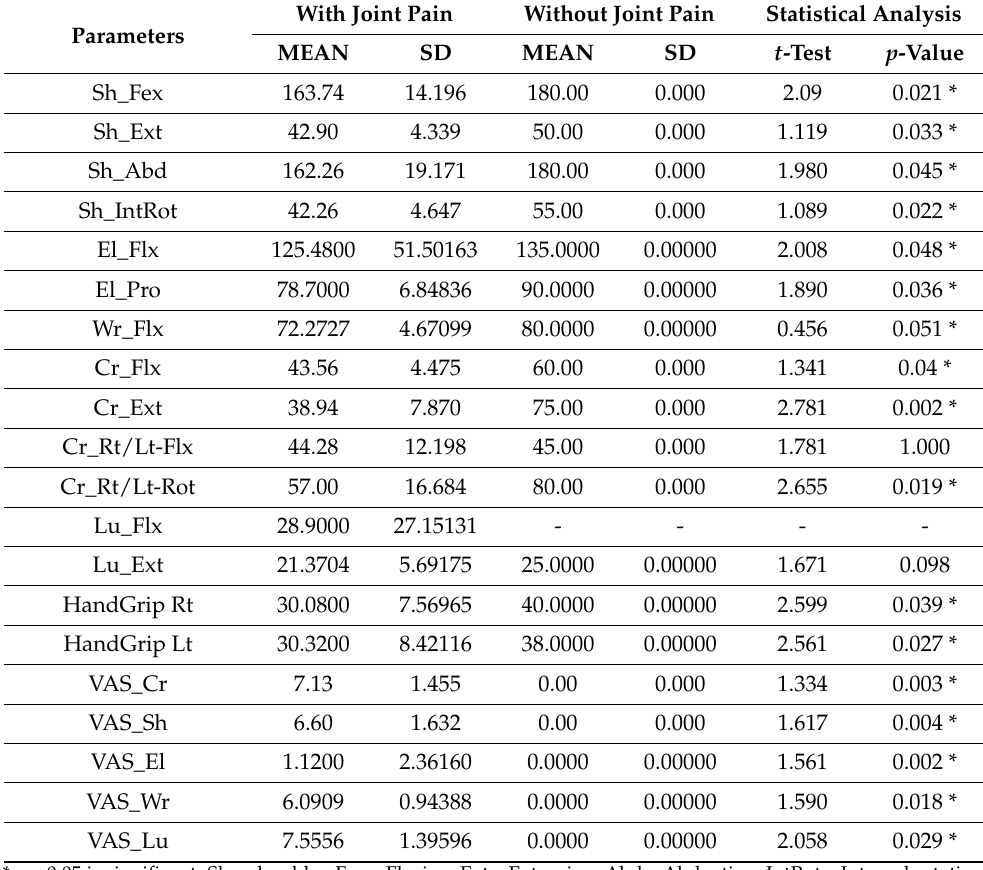
Table 4. Mean values of ROM, hand grip strength & VAS, parameters in both the groups. With Joint Parameters